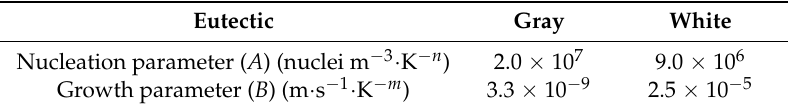
Table 6. Microstructural properties of gray cast iron.